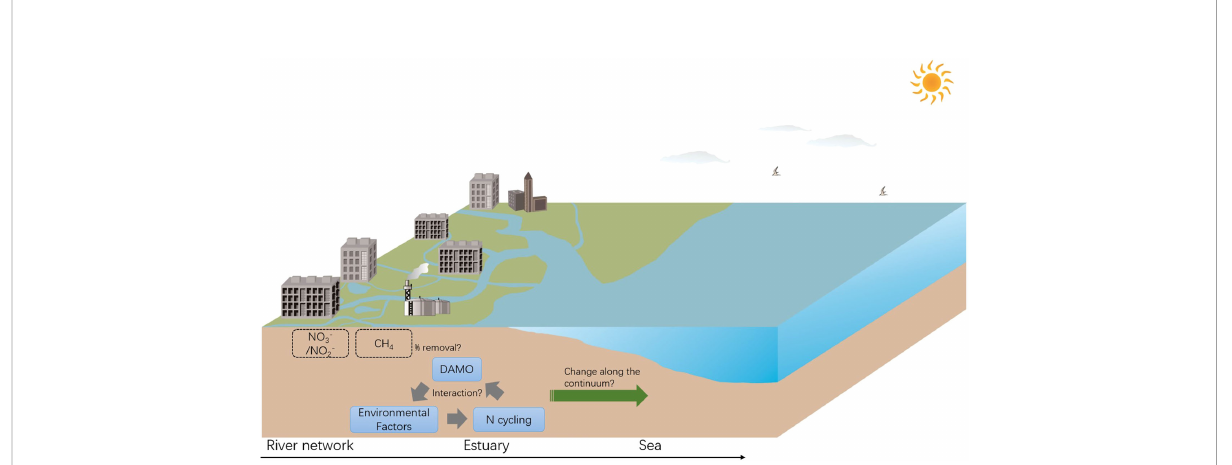
FIGURE 5 Proposed studies focusing on the interactions between DAMO, other N cycling processes, and environmental factors, and their changes along the river-estuary-sea continuum, with implications for CH 4 and reactive N